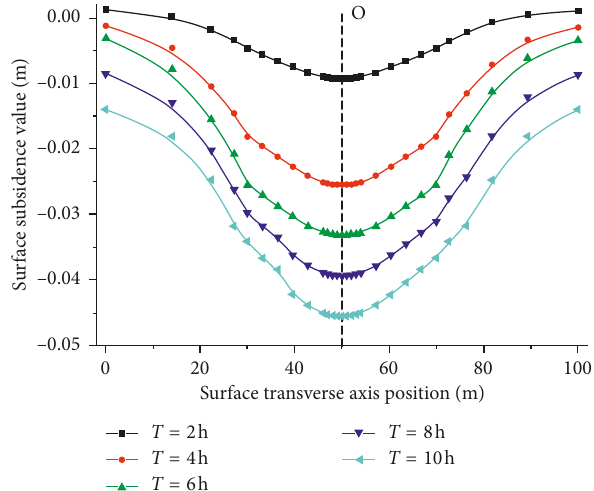
Figure 22: Surface subsidence tank at the reinforcement depth of H � 15m.